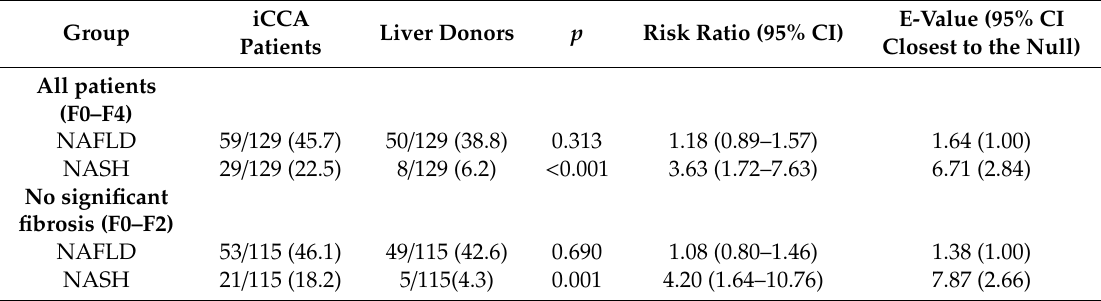
Table 3. Prevalence of non-alcoholic fatty liver disease (NAFLD) and non-alcoholic steatohepatitis (NASH) in patients with resected intrahepatic cholangiocarcinoma (iCCA) without classical risk factors and liver